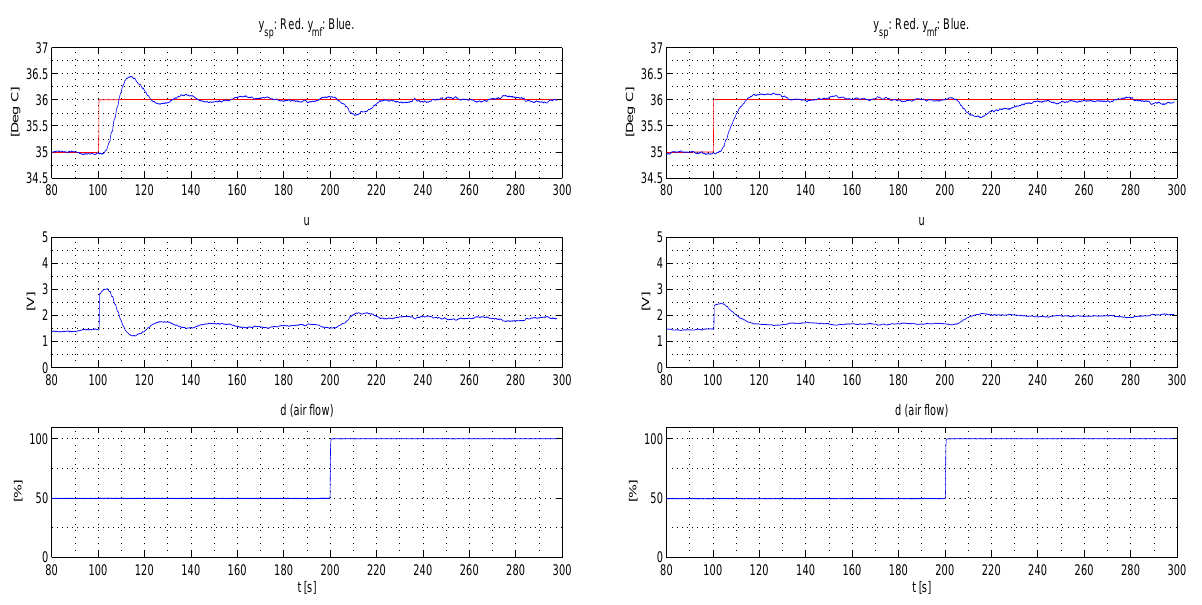
Figure 10: Responses with R-ZN PI settings with k r = 1.